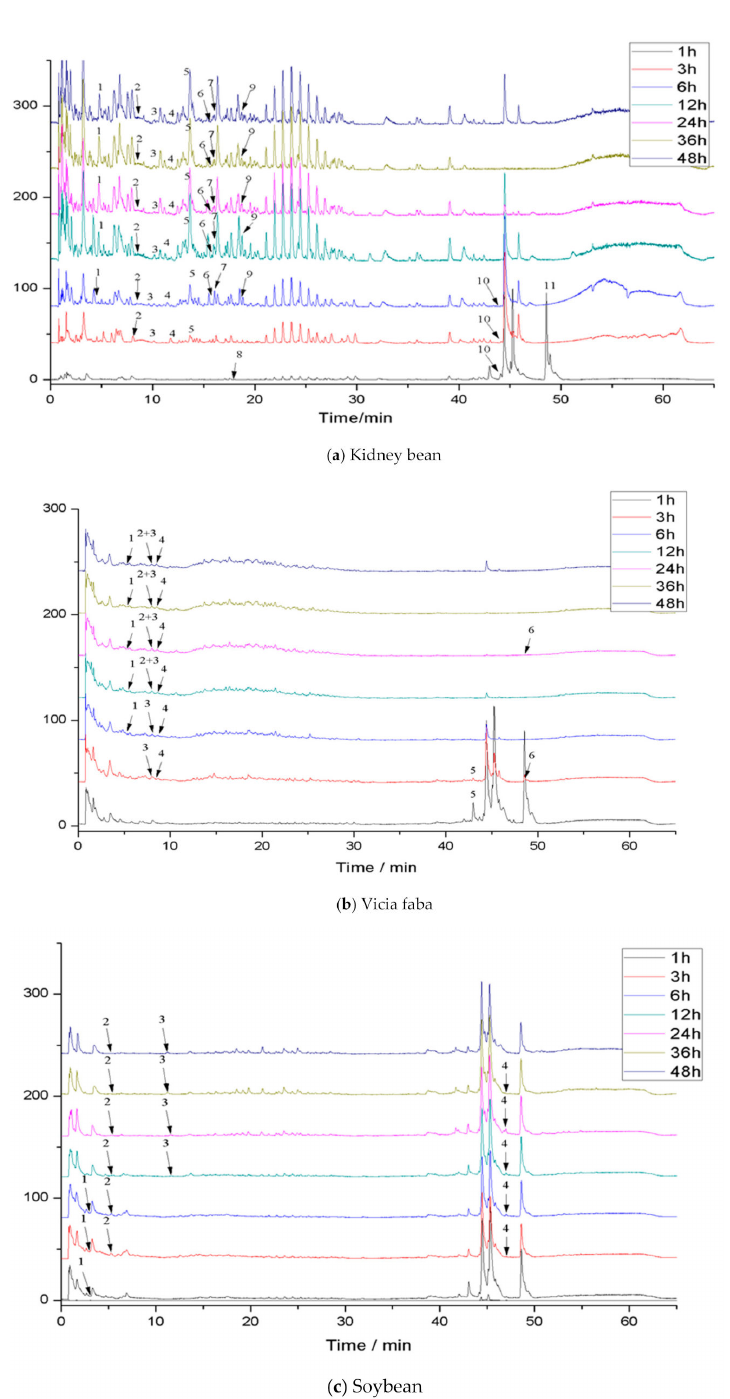
Figure 2. Total ion chromatogram (TIC) of phenolic extracts in legumes after colonic